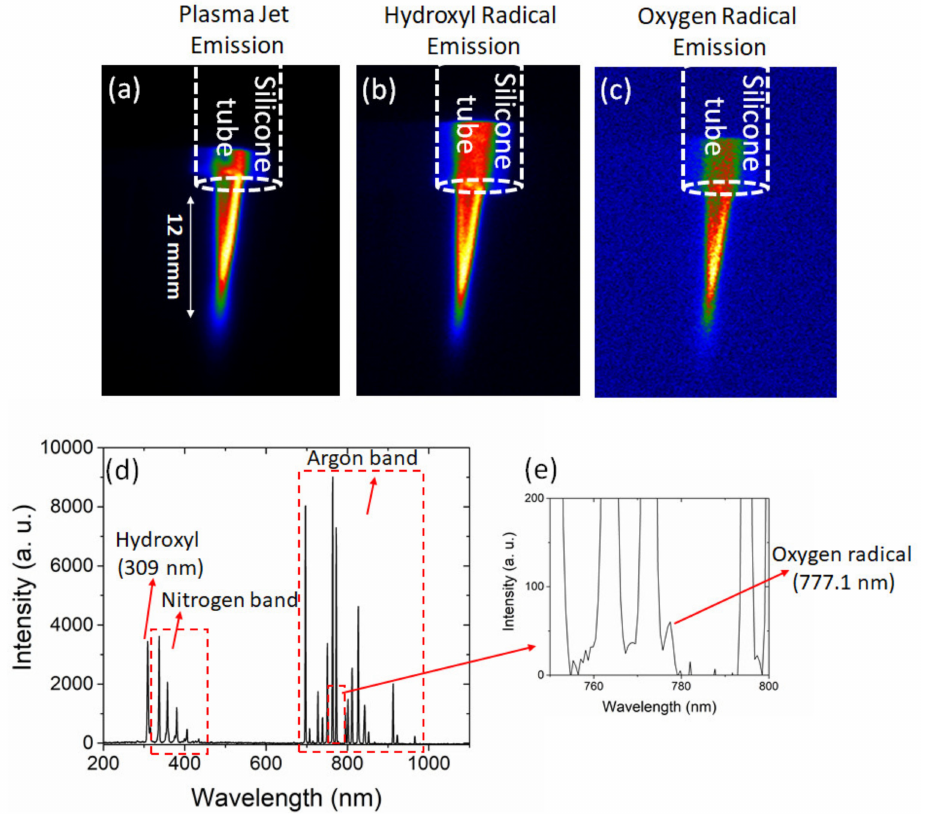
Figure 3. Transferred cold atmospheric plasma (CAP) emission captured by an ICCD camera with an exposure time of 0.5 s. ( a ) Transferred CAP emission without an optical filter. ( b ) Hydroxyl radical emission using an optical filter with 50% transmission. ( c ) Atomic oxygen radical emission using an optical filter with 50% transmission. ( d ) A typical spectrum obtained with a spectrometer during transferred CAP treatment including hydroxyl and ( e ) atomic oxygen